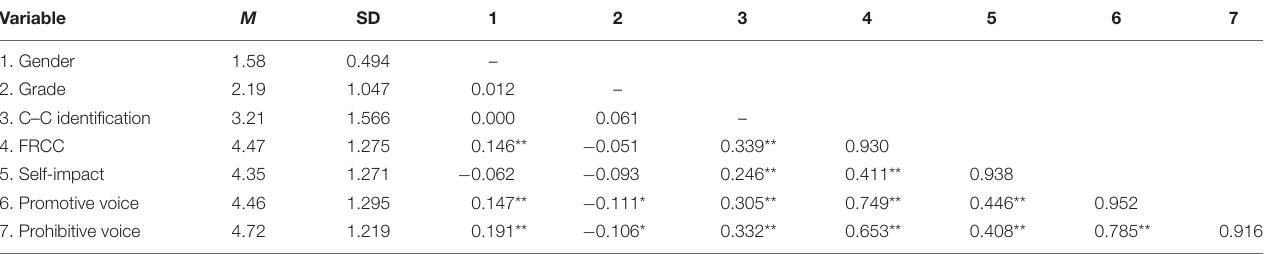
TABLE 2 | Means, standard deviations, and correlations. Variable